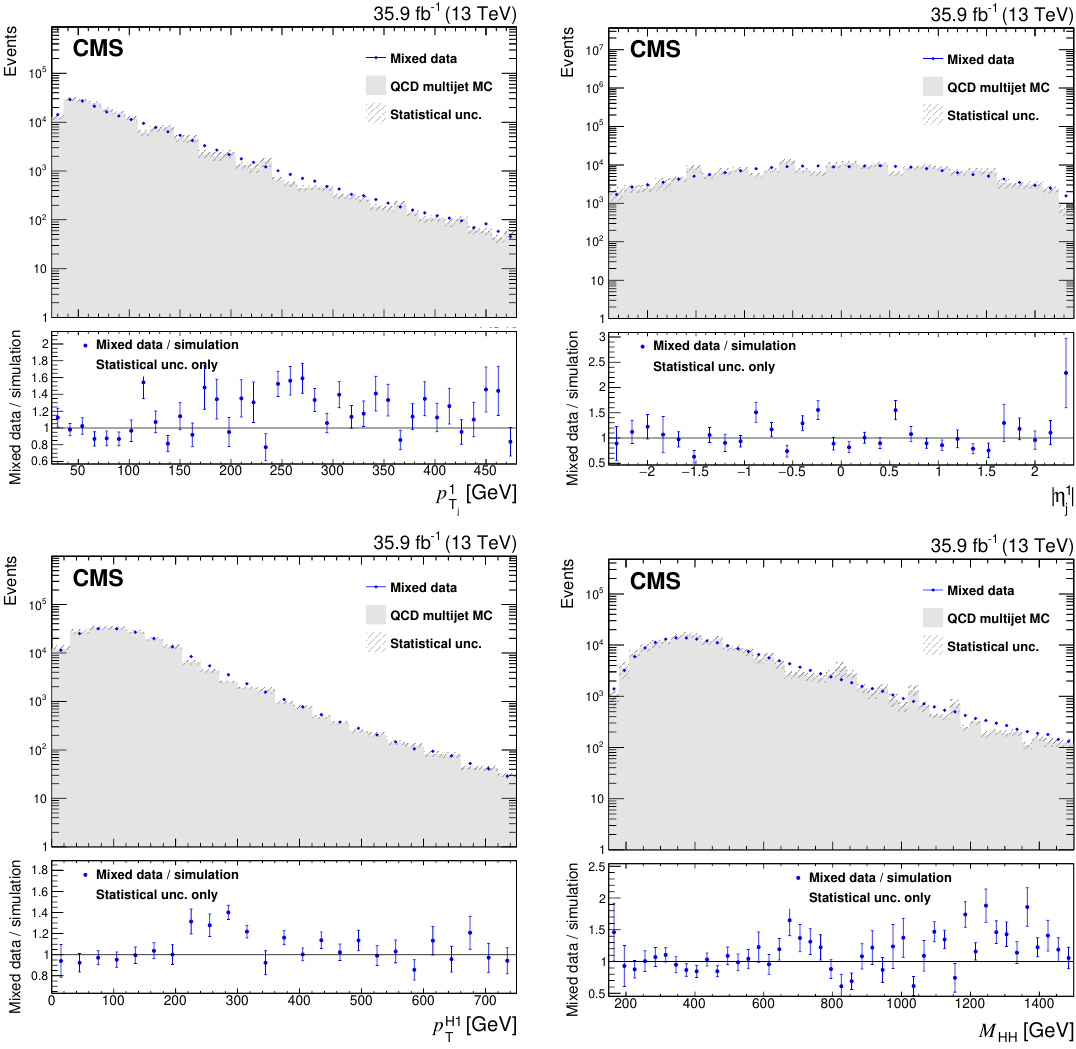
Figure 3 . Comparison between the background model obtained with the hemisphere mixing technique and MC simulation of QCD multijet processes for p T1 p H 1 (lower left), and M HH (lower right). Bias correction for the background model, described T in section 8.2, is applied by rescaling the weight of each event using the event yield ratio be- tween corrected and uncorrected BDT distributions. Only statistical uncertainties are shown as the uncertainties related to the bias correction can not be propagated from the BDT classi(cid:12)er to a di(cid:11)erent